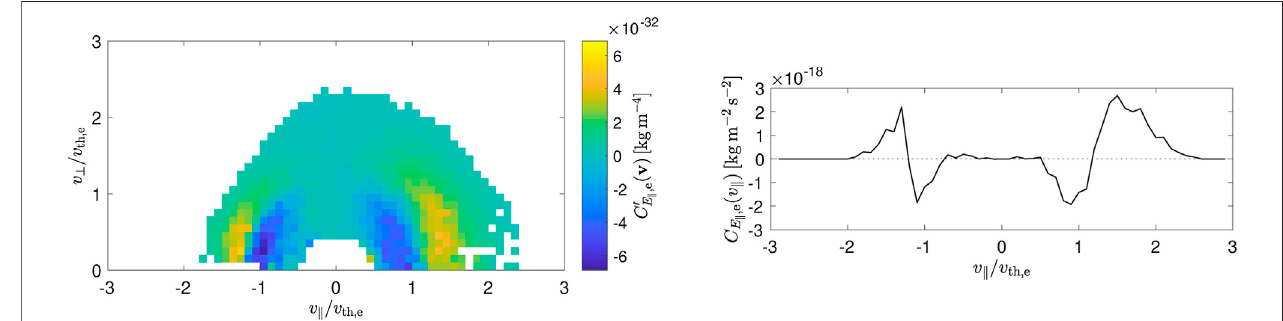
FIGURE 3 | Parallel alternative fi eld-particle correlation for electrons, C E (cid:3) , e ′ ( v (cid:3) , v ⊥ ) , measured in the Earth ’ s magnetosheath from MMS data (left). Same data integrated over v ⊥ and converted to the standard fi eld-particle correlation C E (cid:3) , e ( v (cid:3) ) . Both show a clear signature of electron Landau damping at v (cid:3) ~± v th , e . Figures from Chen et al.